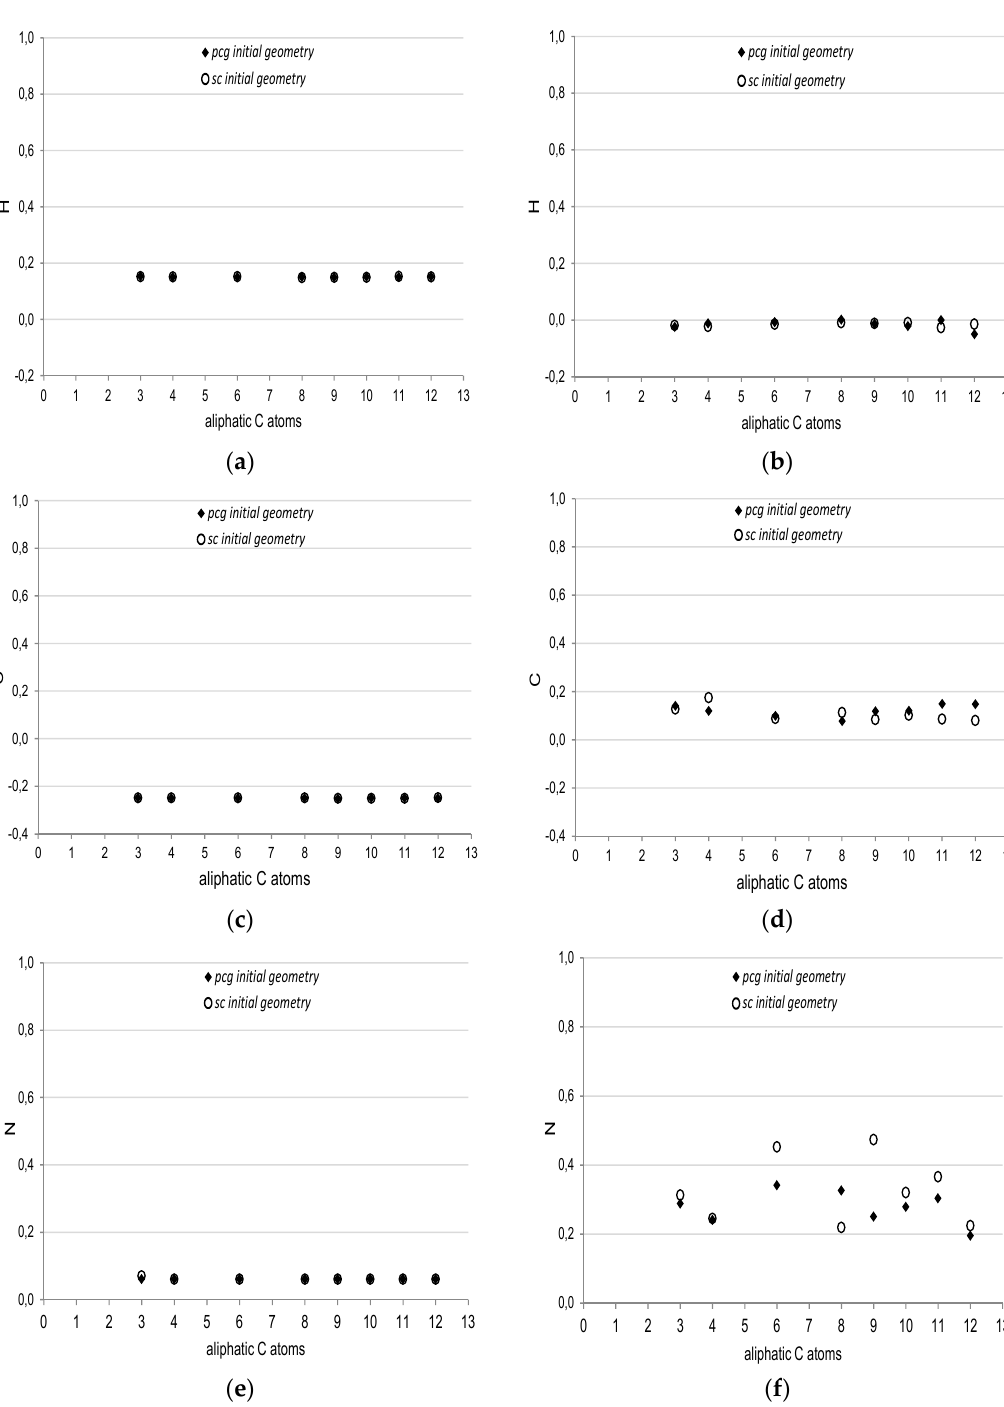
Figure 5. Average partial charges calculated with a DFT based approach calculated average partial charges on H (( a ) Löwdin, ( b ) electro static potential (ESP)) and C (( c ) Löwdin, ( d ) ESP) of the ammonimum group and partial charges on N (( e )Löwdin, ( f ) ESP) as a function of the carbons in the AATEABs aliphatic chain.